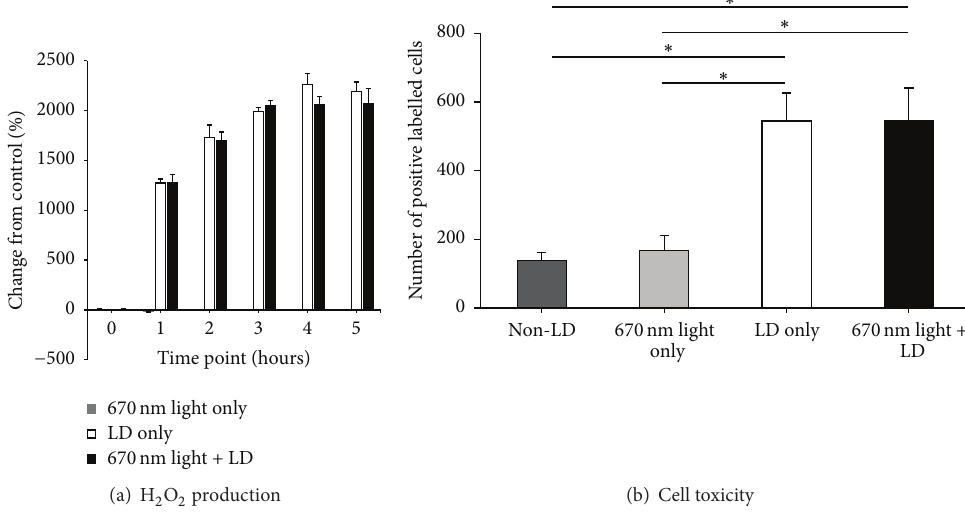
Figure 6: (a) The effect of 9J/cm 2 of 670 nm light and light damage on H 2 O 2 production in 661 W photoreceptor cells is shown here where bars represent the percentage change of H 2 O 2 production when compared to nonlight damaged cells. Light damage significantly increased H 2 O 2 production in the cells directly after one hour of light exposure. H 2 O 2 production steadily increased amongst light damaged cells, both treated and nontreated, with increasing time under bright light conditions ( 𝑛 = 3 for all groups; each run consisted of duplicate wells for each group; “ ∗ ” denotes significance using one-way ANOVA with Tukey’s post hoc test, 𝑃 < 0.05 ; error bars represent SEM). (b) There was an increase in cell toxicity in light damaged (LD) cells, both treated and nontreated, when compared to nonlight damaged cells. 670 nm light did not significantly decrease cell toxicity in control or light damaged conditions ( 𝑛 = 3 for all groups; each run consisted of duplicate wells for each group; “ ∗ ” denotes significance using one-way ANOVA with Tukey’s post hoc test, 𝑃 < 0.05 ; error bars represent